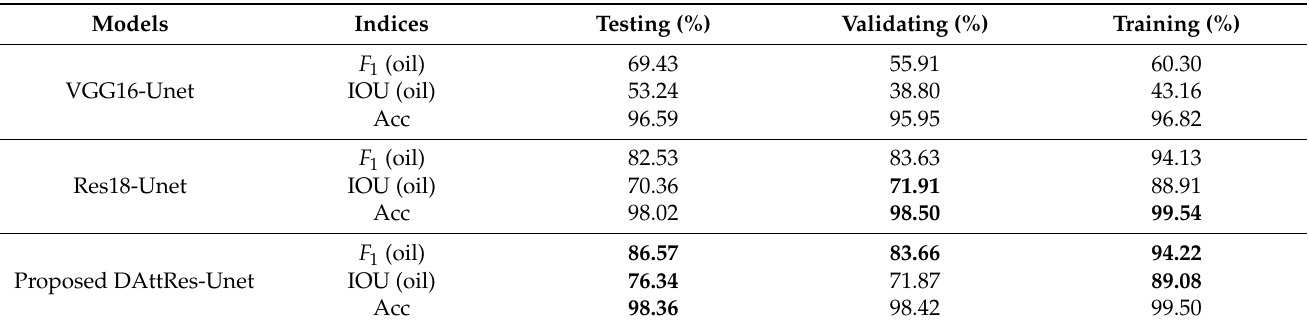
Table 2. Performance indices of VGG16-Unet, Res18-Unet, and the proposed DAttRes-Unet on testing, validating, and training data.